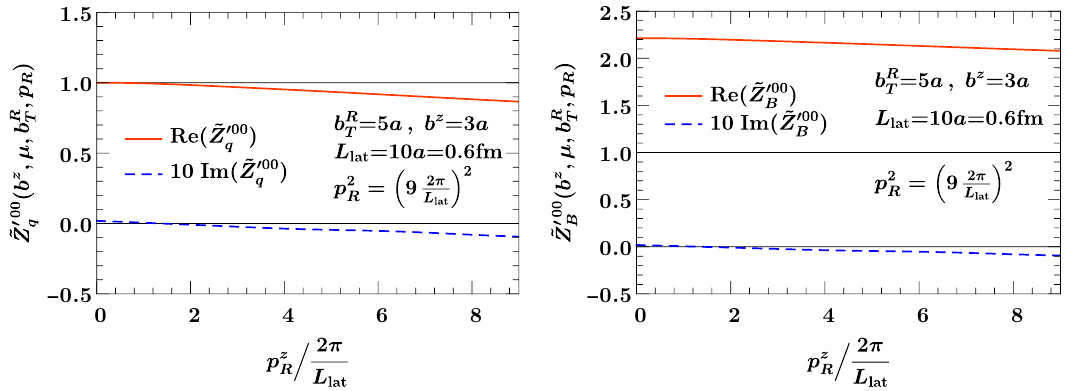
Figure 5. One-loop conversion factors ~ Z 0 from the RI 0 /MOM scheme to the MS scheme for the quasi-TMDPDF (left) and the quasi-beam function (right), as a function of the z momentum, p z of the quark